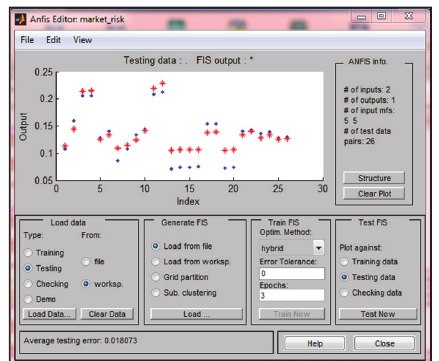
Fig. 4. The Output of Insurance (or Underwriting) Risk Neuro-Fuzzy Network for Testing Data